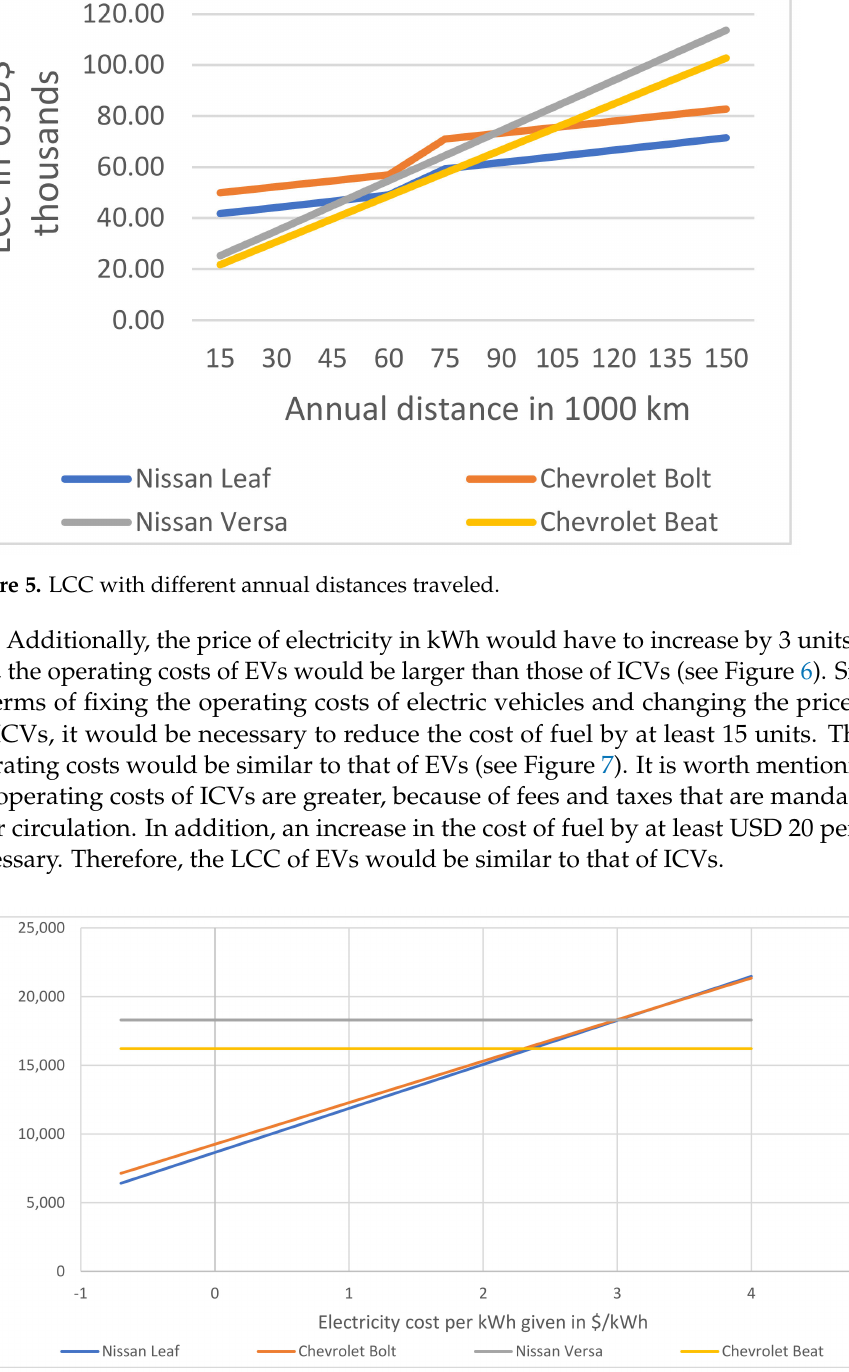
Figure 6. Operation cost with electricity price variations with the fuel cost fixed at USD